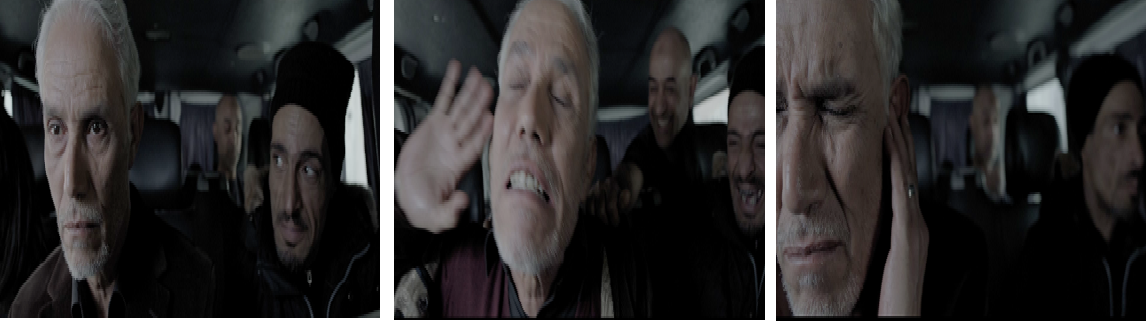
Figure 10: Hallucinations of Bechir imagining himself in contact with the